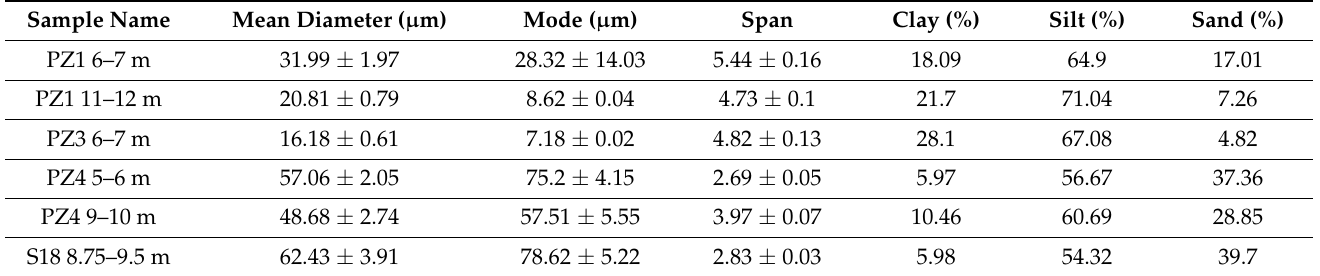
Table 1. Summary of laser diffraction grain size analysis ( ± values refer to standard deviation).